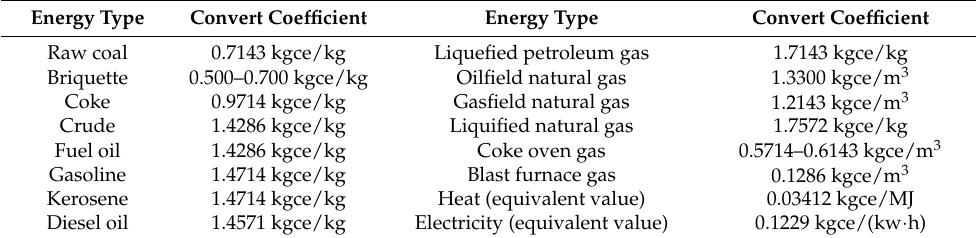
Table 1. Reference coefficient of various energy discount standard coal.